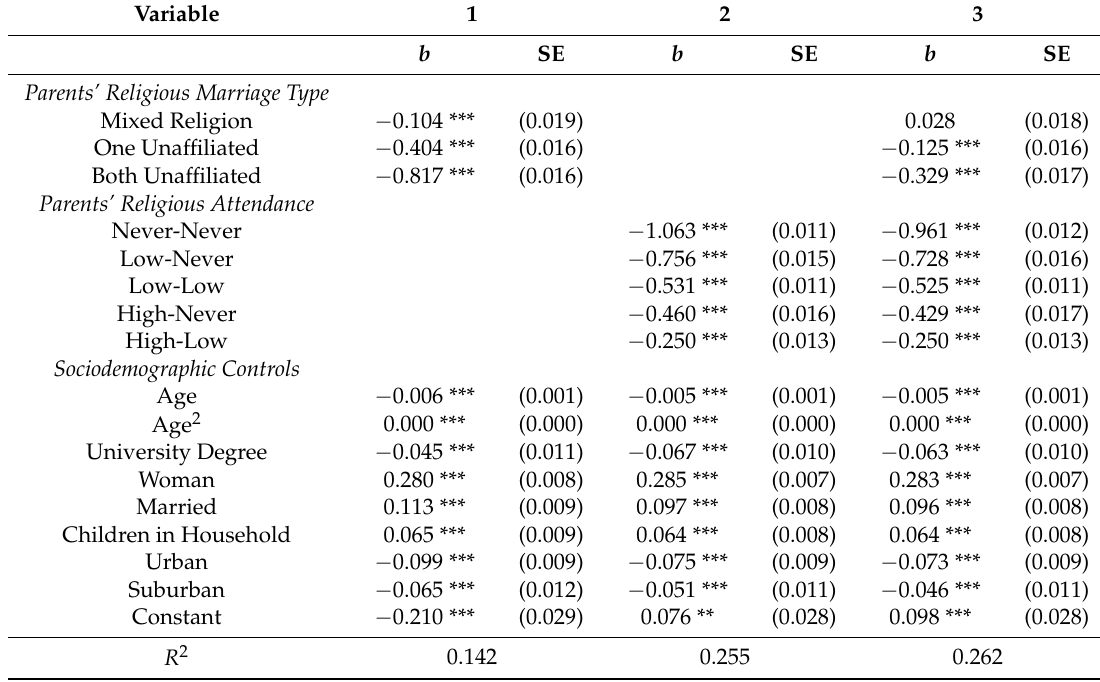
Table 2. Results from fixed effects regression models predicting respondent